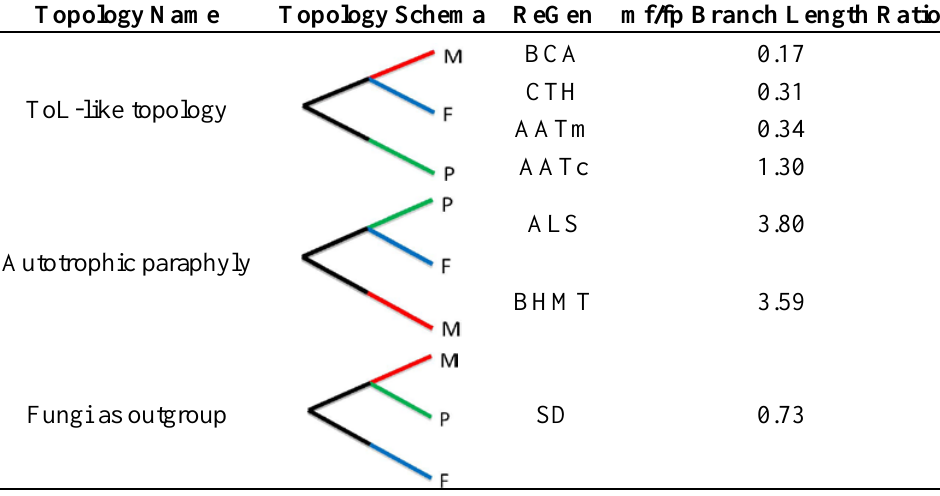
Table 3. Summary of maximum likelihood (ML) tree